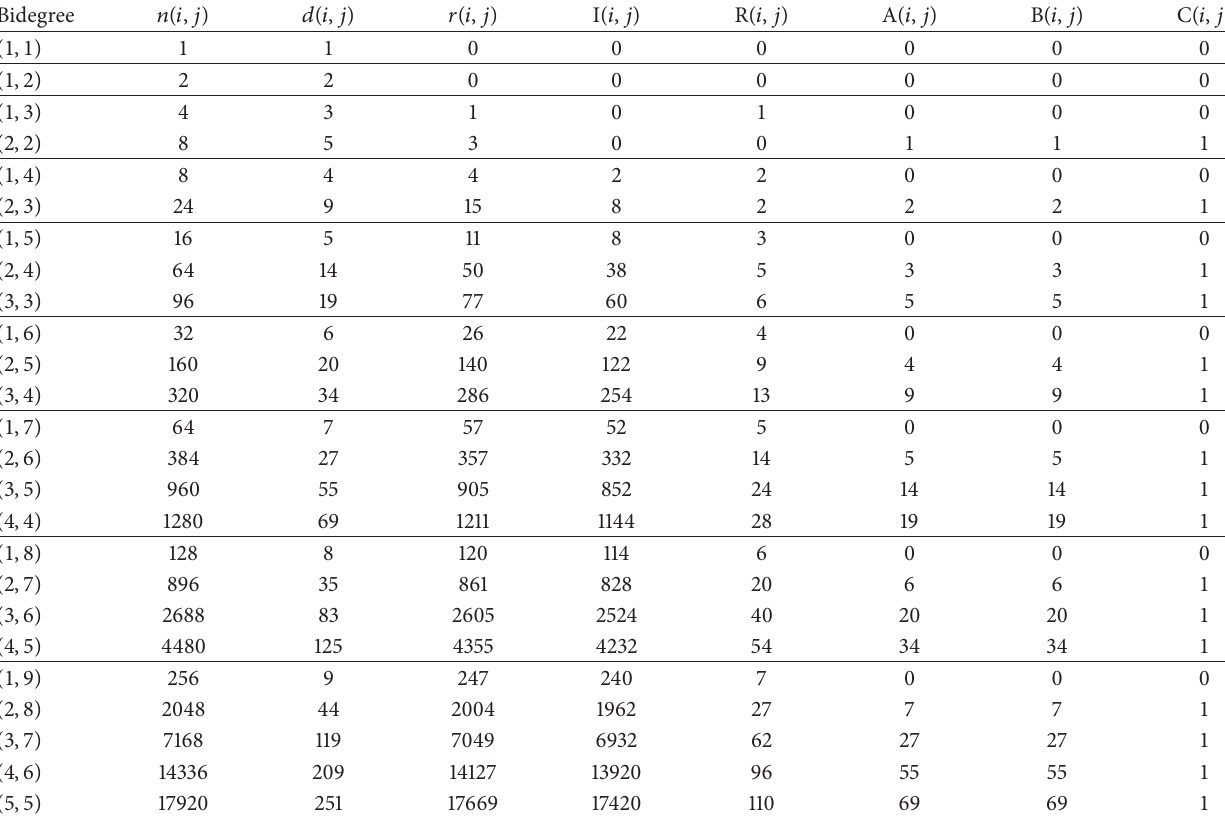
Table 1: A few numbers relative to the analysis of the identities obtained by our procedure, for [𝑦,𝑥] 𝑞 -centered 𝑞 -mutators of total degree ≤